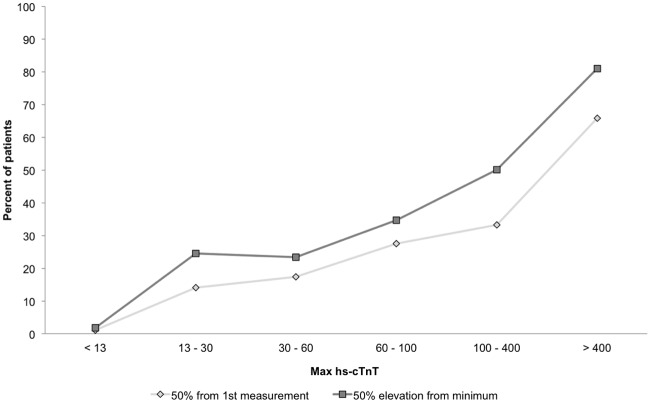
Relative change by maximal high sensitivity troponin levels.The percent of admissions having hs-cTnT dynamics of 50% or more from minimum value or from admission baseline correlates with the maximal hs-cTnT level, p for trend <0.0001 for both.